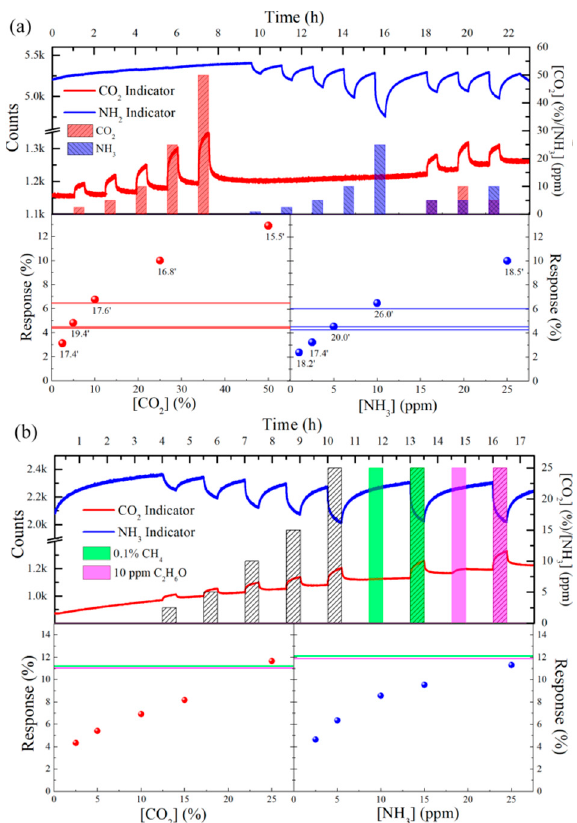
Figure 2. Dynamic response of the NH 3 (blue line) and CO 2 (red line) colorimetric sensors under different concentrations and cross-interference experiments ( a ) between them ( b ) and with methane (CH 4 ) and ethanol (C 2 H 6 O). Lower panels show the response values and times for both sensors (circles and minutes) together with the responses obtained in the cross-interference experiments (horizontal lines). Data acquired with the green LED operating at 41